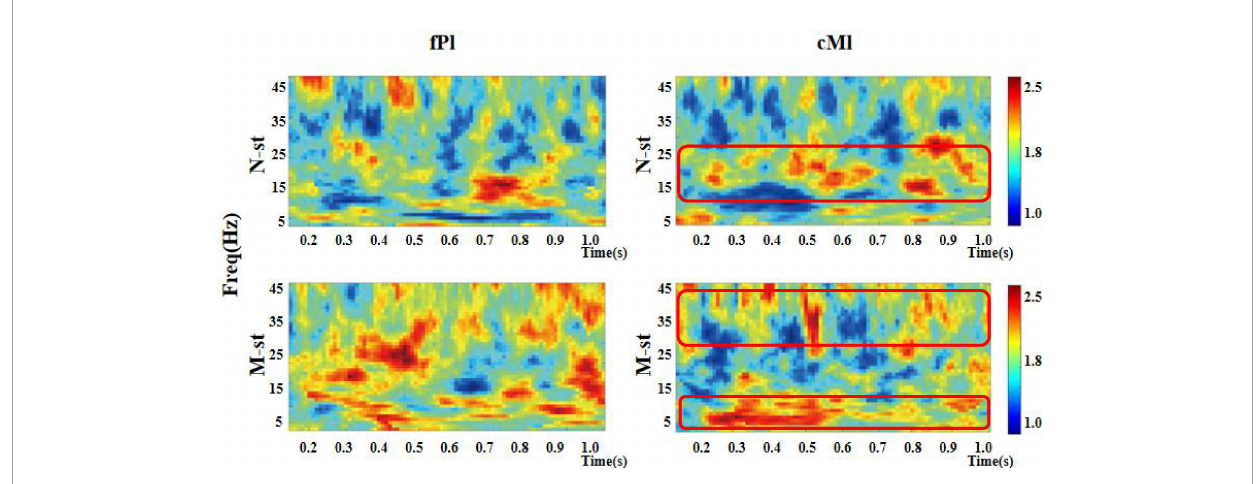
FIGURE6 Time-frequency distribution of ITPC in prefrontal and parietal regions. "fPl" represents the prefrontal parietal lobe area, "cMl" represents the parietal motor cortex. "M-ST" represents the true meaning sound stimulation group, and the "N-ST" band represents nouns stimulation group. It can be seen from the figure that the ITPC values of the "M-ST" group in the frontal parietal lobe region are in a high state in all frequency bands. In the parietal motor cortex, ITPC values of M-ST group and N-ST group were different. The red boxes represent areas with high ITPC values.